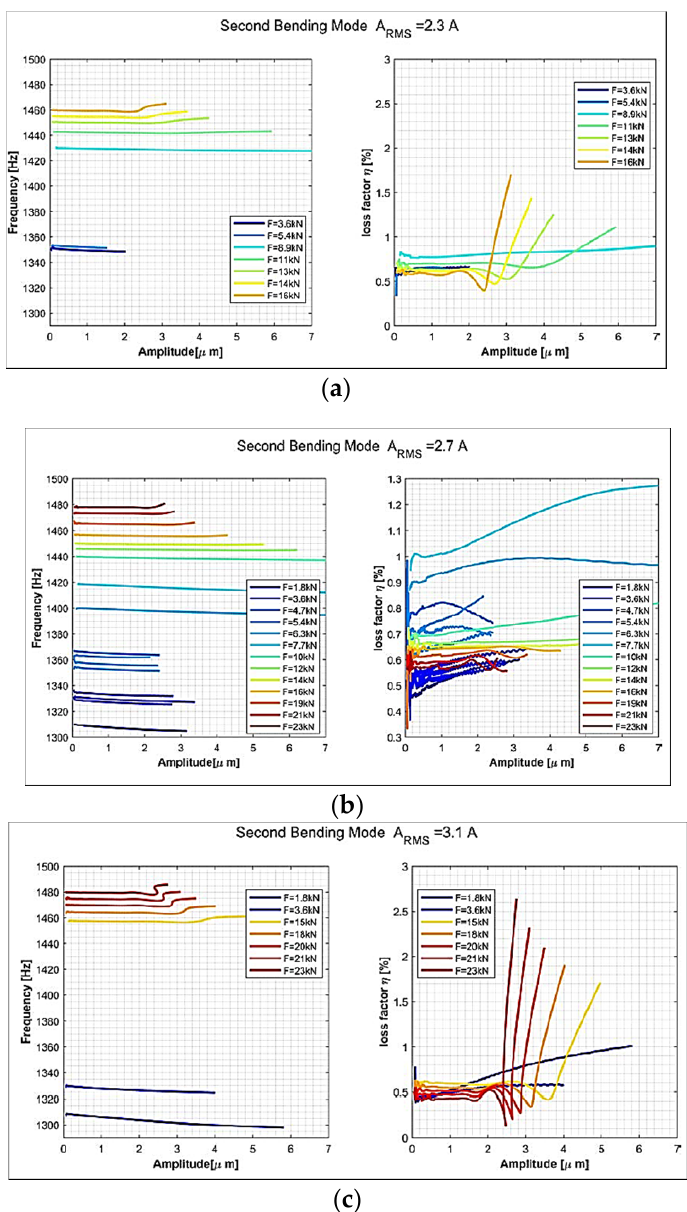
Figure 11. Frequency and damping versus vibration amplitude for different values of effective I_RMS : ( a ) I_RMS = 2.3 A, ( b ) I_RMS = 2.7 A, and ( c ) I_RMS = 3.1